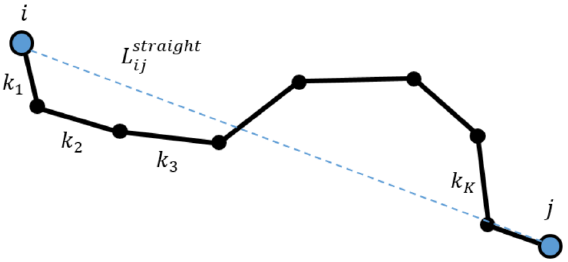
Figure 4. Schematic representation of the segments subdivisions.